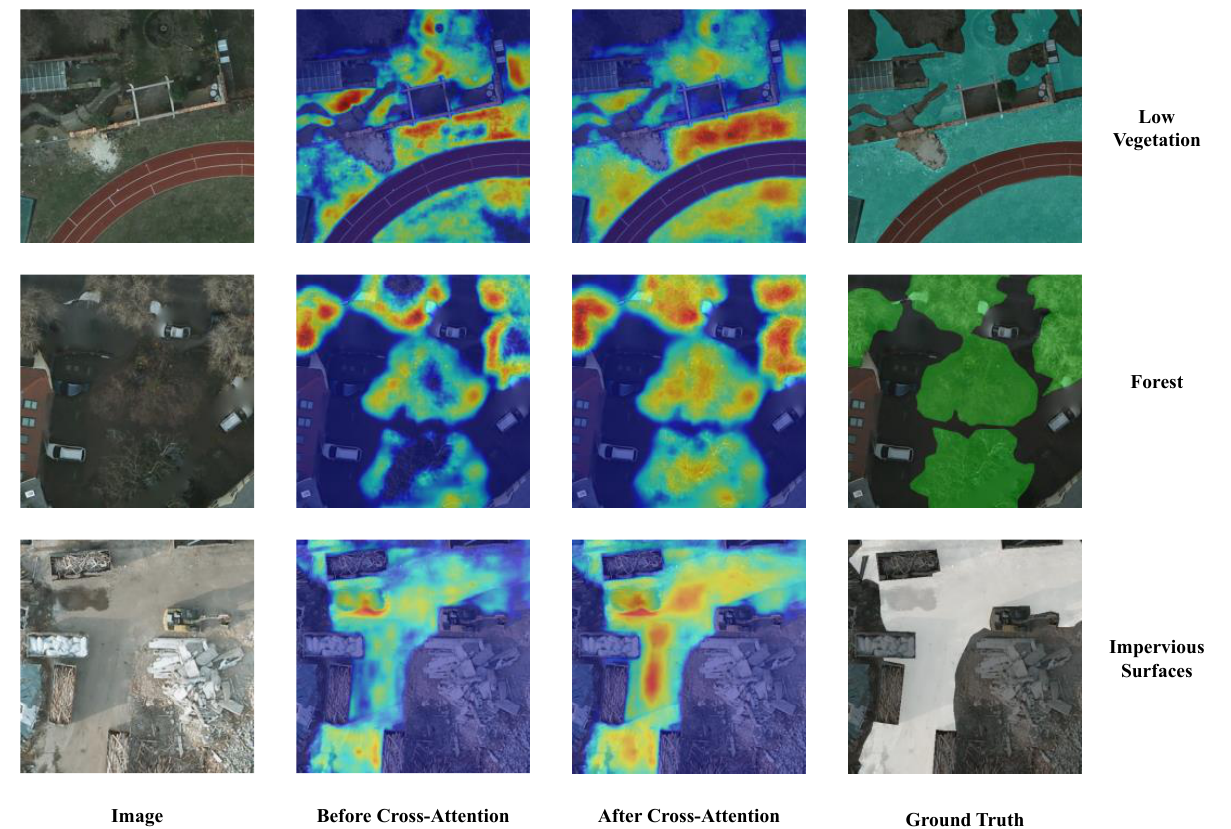
Figure 8. Examples of class activation maps (CAM) on the Potsdam validation set.